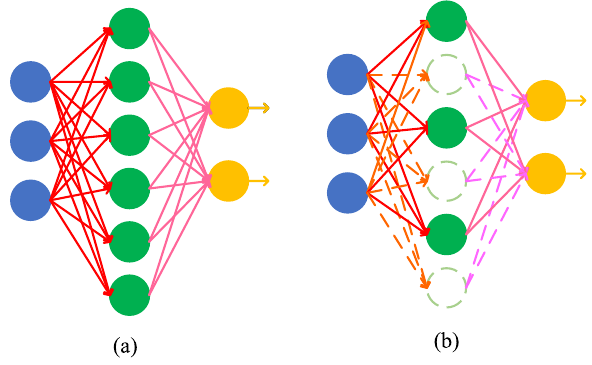
Figure 6. The principle of dropout: ( a ) real network layer; ( b ) network layer through